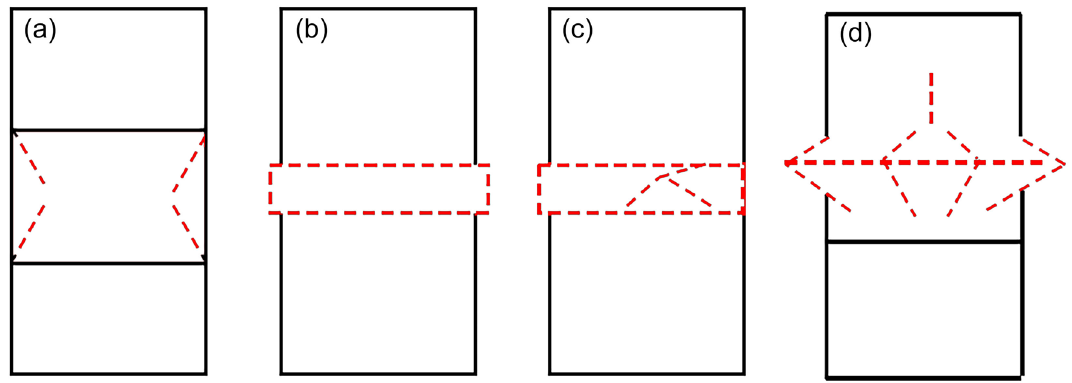
Figure 11. Possible failure modes of composite rock mass specimens with horizontal interlayer under uniaxial compression.